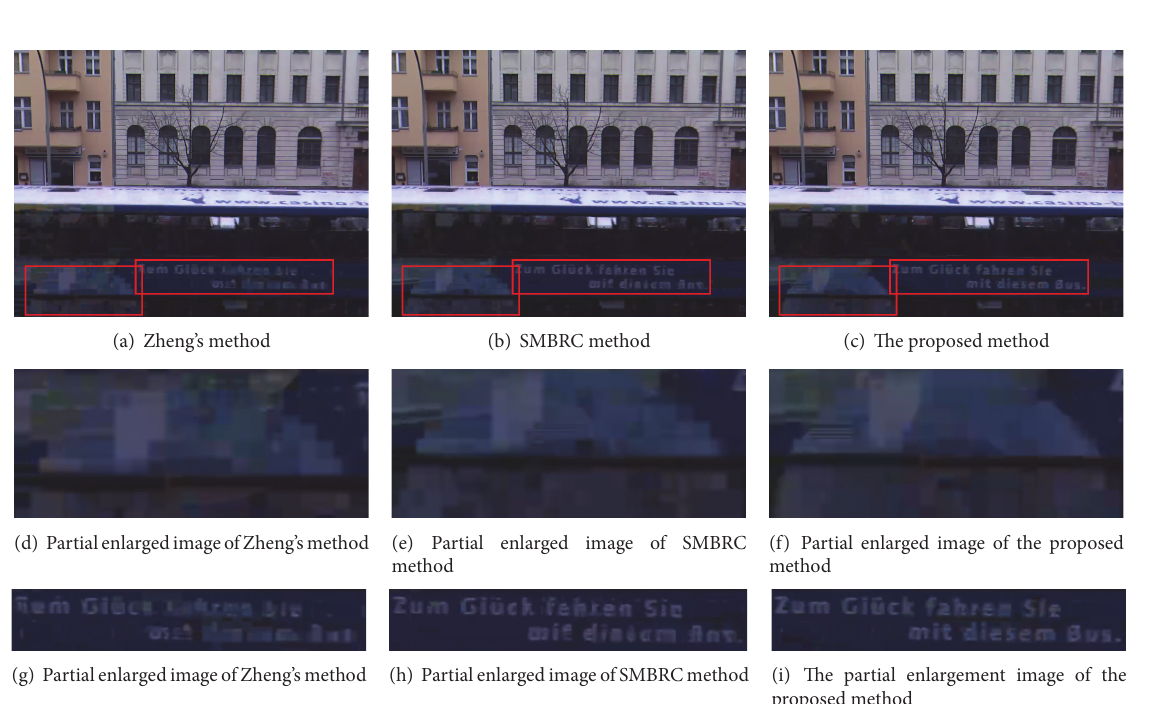
Figure 6: The subjective image comparison among three methods of AltMoabit sequence (QP = 37, the 52th frame in the view